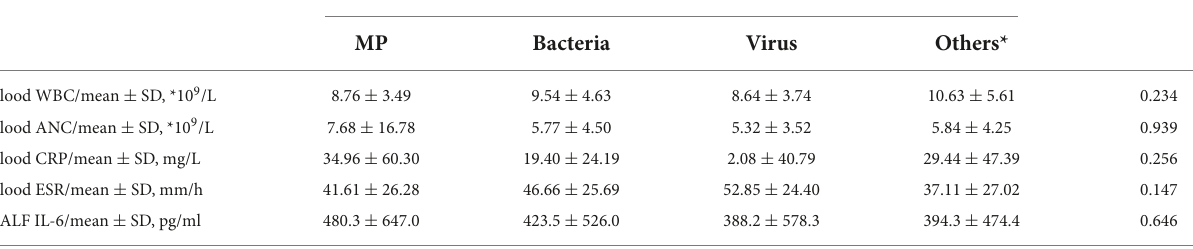
TABLE 4 Comparison of blood WBC count, ANC, CRP, ESR, and BALF IL-6 levels across different pathogen-detected categories. Biomarkers or cytokines